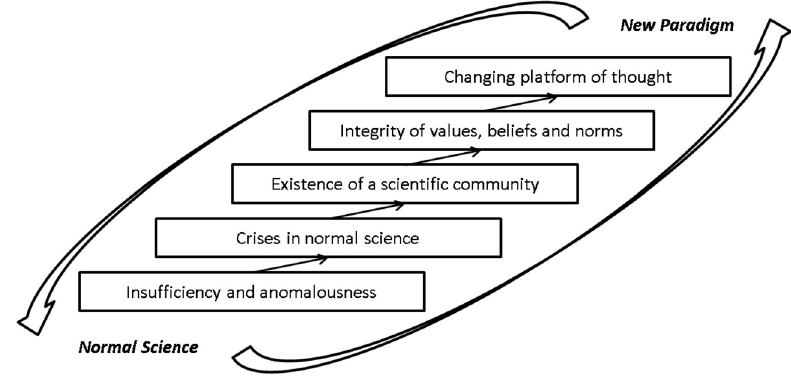
Fig. 1 Stages of the scientific